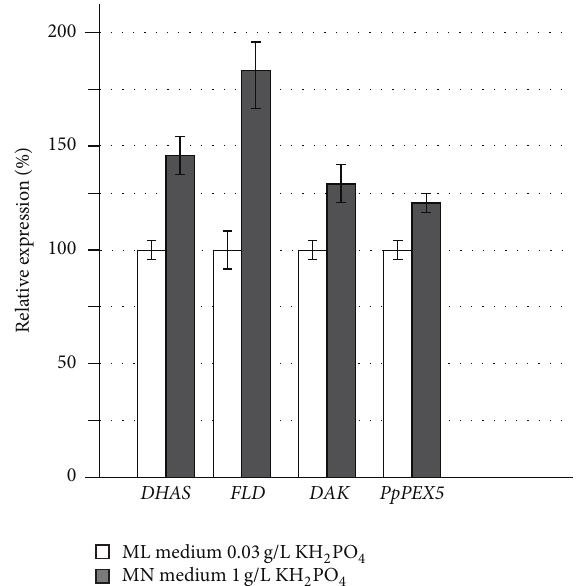
Figure 2: Quantitative analysis of the relative expression levels of PpDAK , PpDHAS , PpFLD , and PpPEX5 genes depending on KH 2 PO 4 concentration in the medium. MN media contained 1g/L KH 2 PO 4 and 1% methanol. ML media contained 0,03 g/L KH 2 PO 4 and 1%